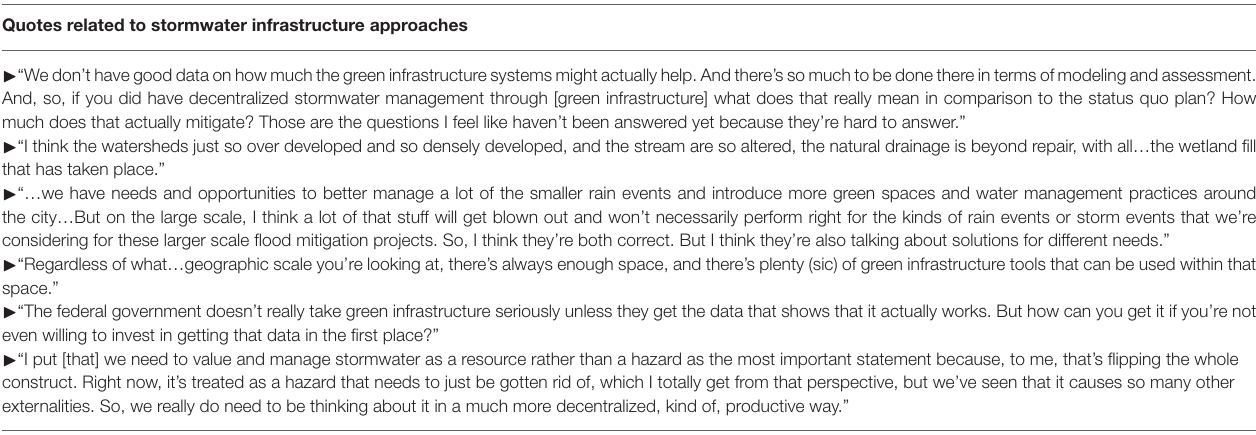
TABLE 9 | Notable quotes from study participants regarding their ideas about various aspects of stormwater